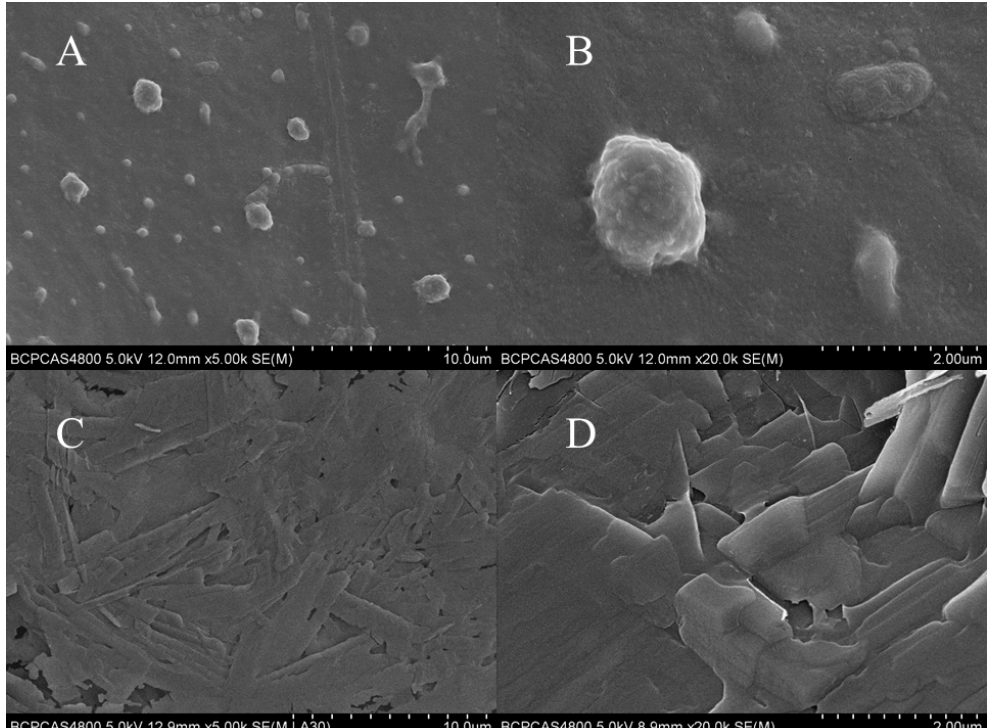
Figure 4. SEM images of the outer membrane surface of the zebrafish embryo ( n = 5) after incubation for 8 h. ( A , B ): Blank control in the reconstituted medium. ( C , D ): 1.0 mM PFLX.